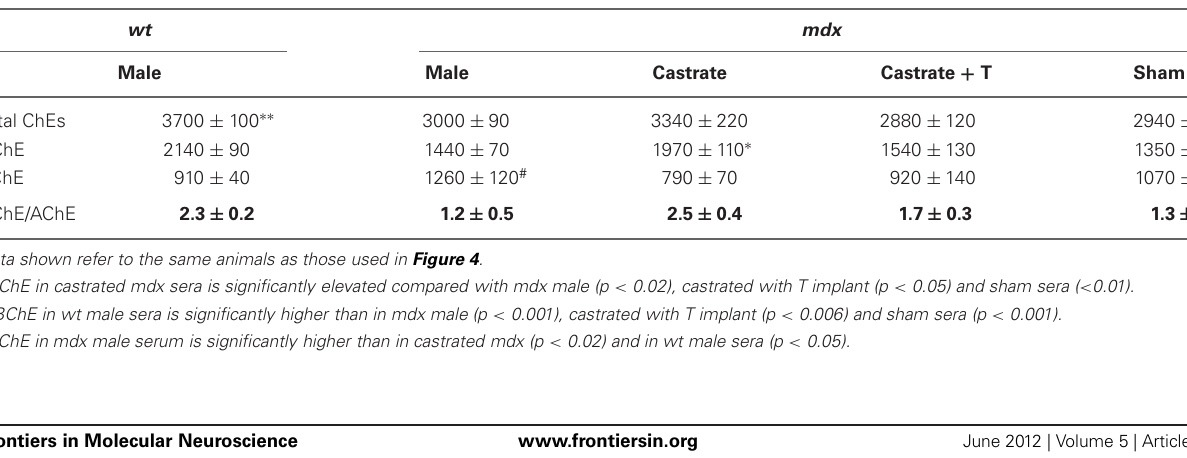
( Figure 4 ): thus, the agonadal “baseline” level in mdx mice was significantly below the baseline level in wt agonadal mice (29%, p < 0 . 002). It was slightly lower than the level in control wt mice (14%, p = 0.06) or in sham-operated wt mice. As in wt mice,